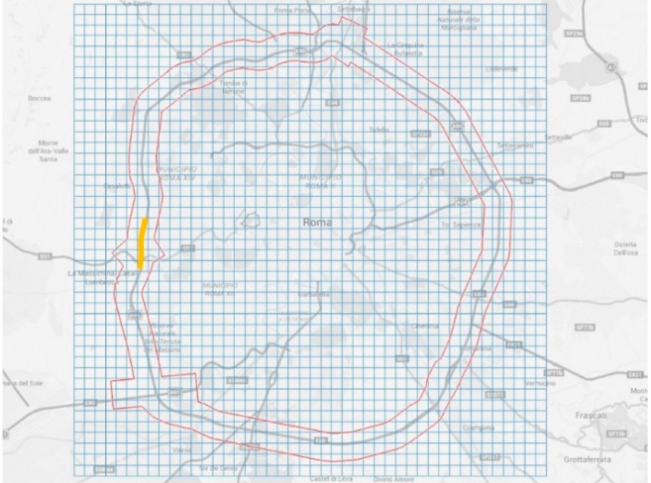
Figure 5. Basic noise maps preparation: generate a unique grid for the whole pilot area ( a ) and prepare a unique calculation area ( b ).